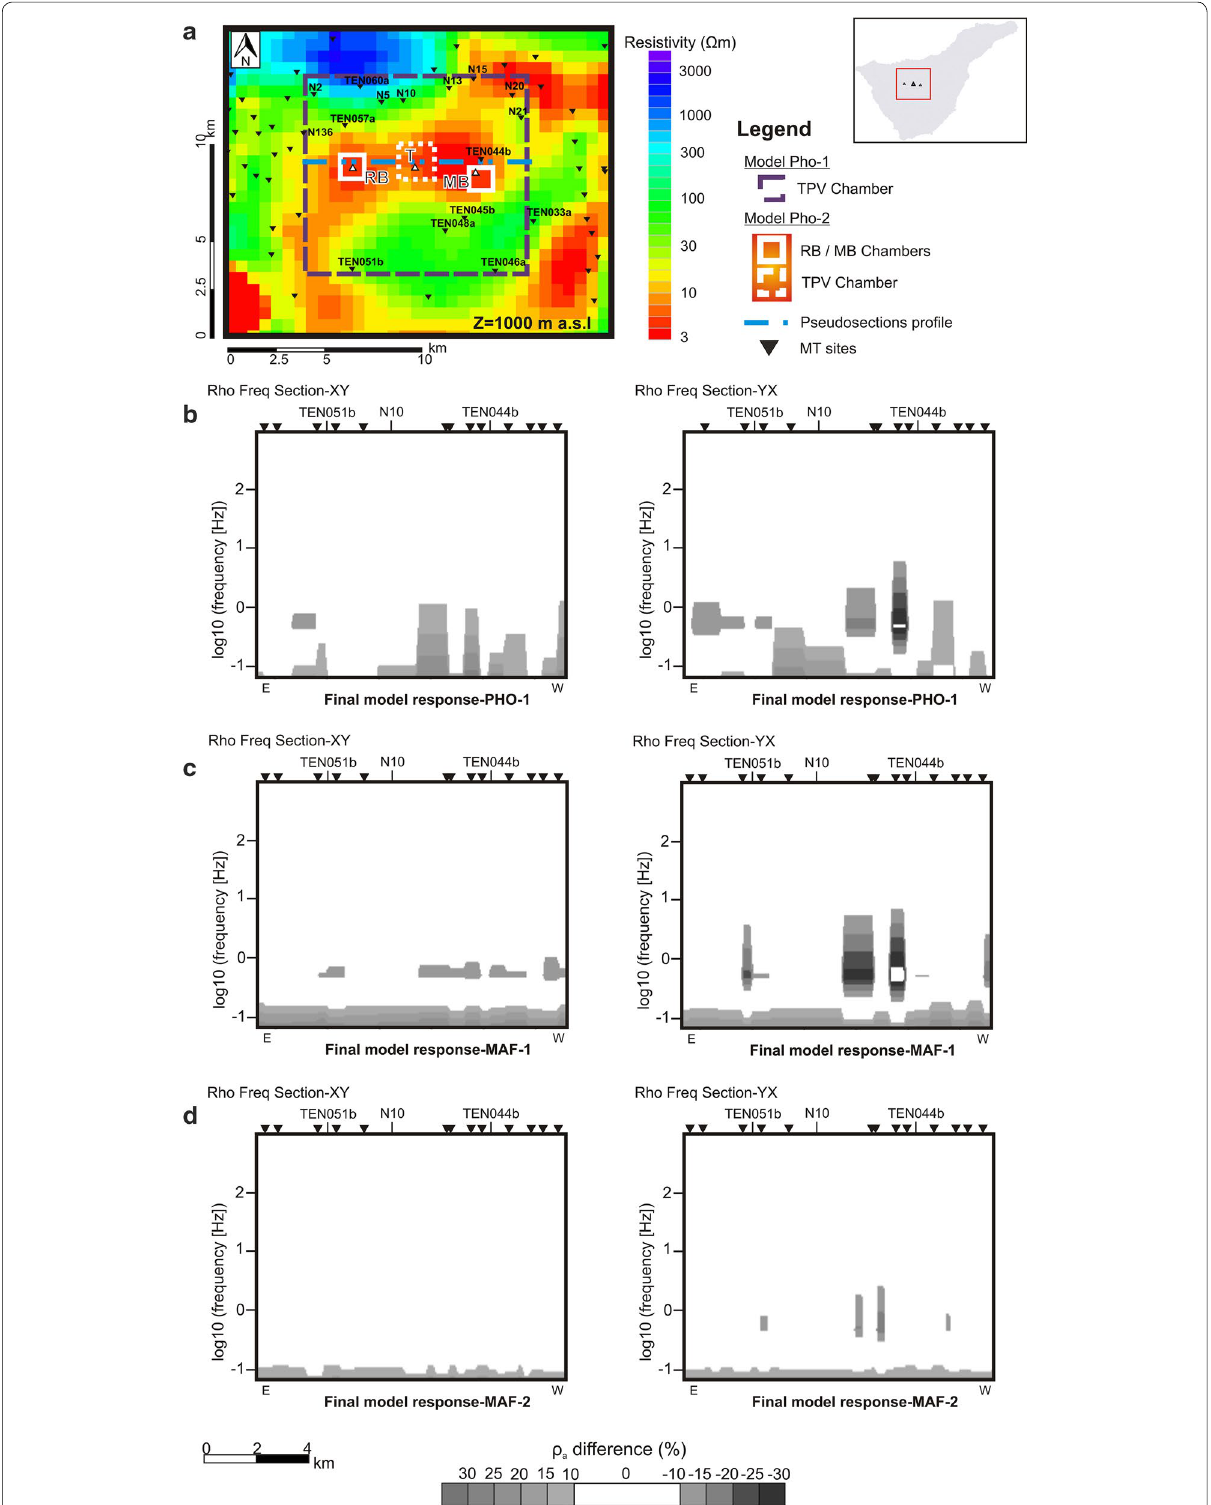
Fig. 3 Pseudosection plots of the apparent resistivity difference between original and modified models. a Plan view of the 3‑D resistivity model at 1 km a.s.l. Black triangles: MT sites recorded; white squares: potential magma chambers; blue line: EW profile used to plot the results. b Difference between original and PHO‑1 models. c Difference between original and MAF‑1 models. d Difference between original and MAF‑2